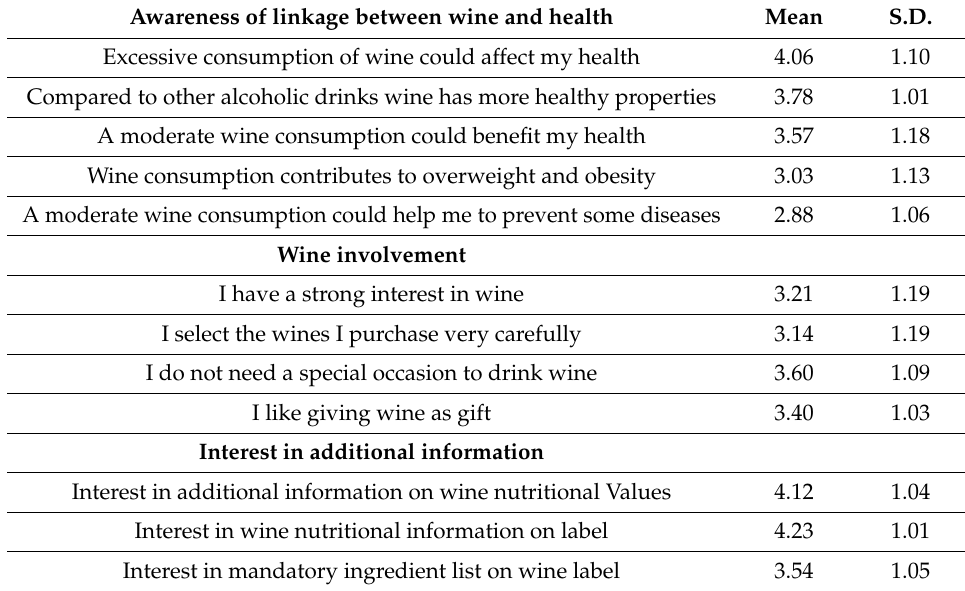
Table 3. Wine related